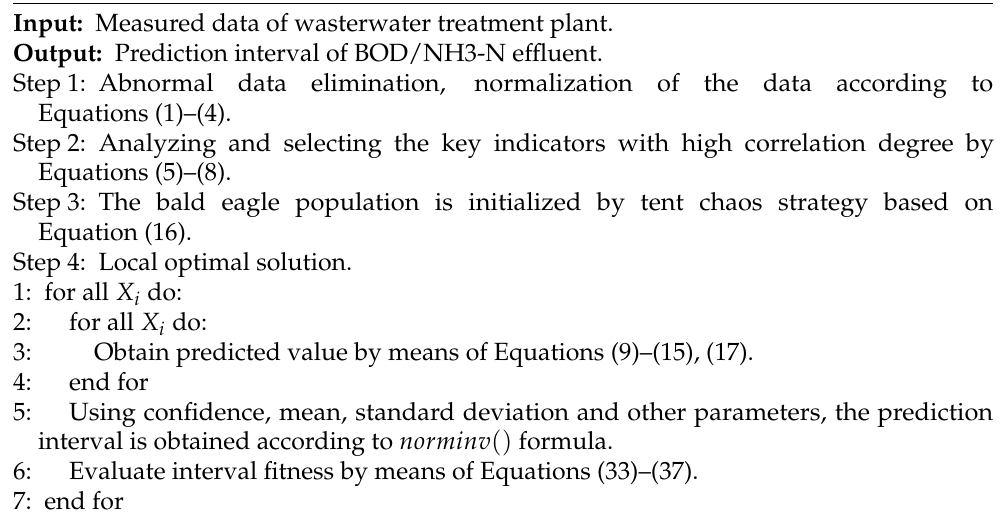
Algorithm 1 LUBE interval prediction based on IBES-LSSVM